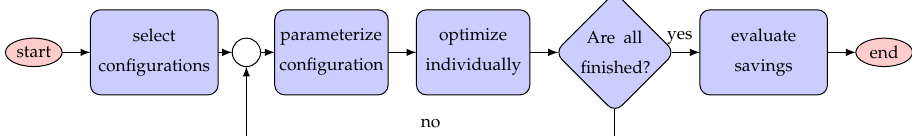
Figure 1. Simplified flowchart illustration of the proposed optimization